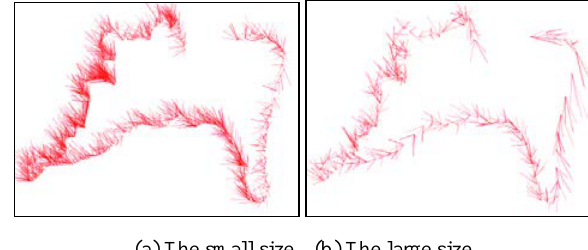
Figure 9. Rendering results with various